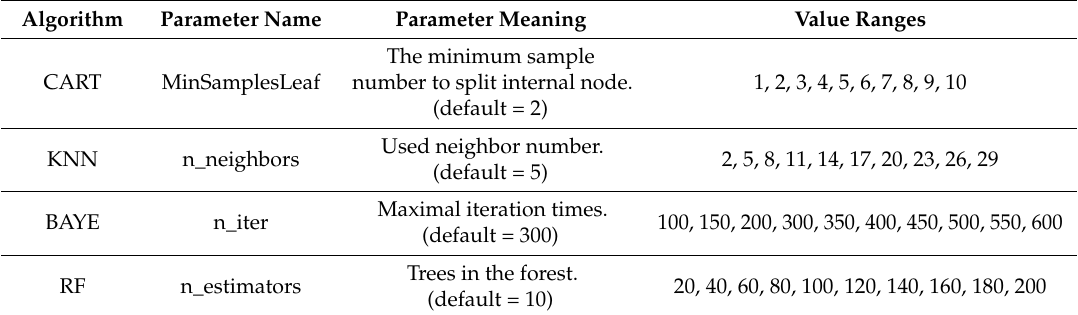
Table 1. Parameter ranges of classification and regression trees (CART), k-nearest neighbor (KNN), Bayesian (BAYE) and random forest (RF)